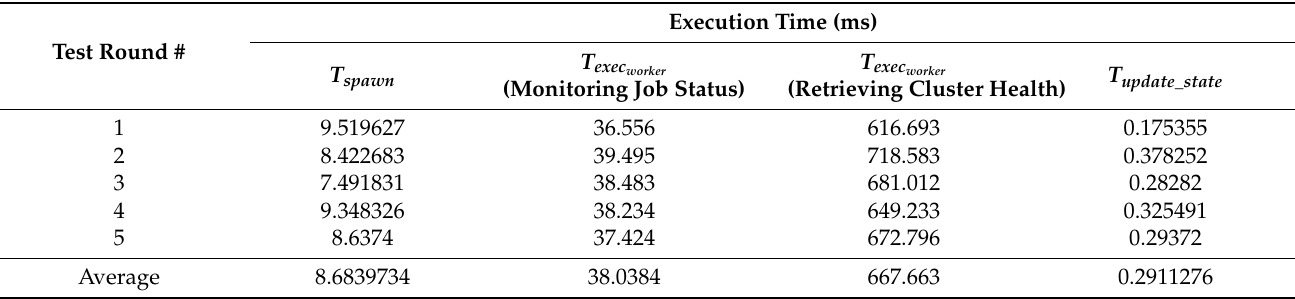
Table 4. Execution time of System Monitoring